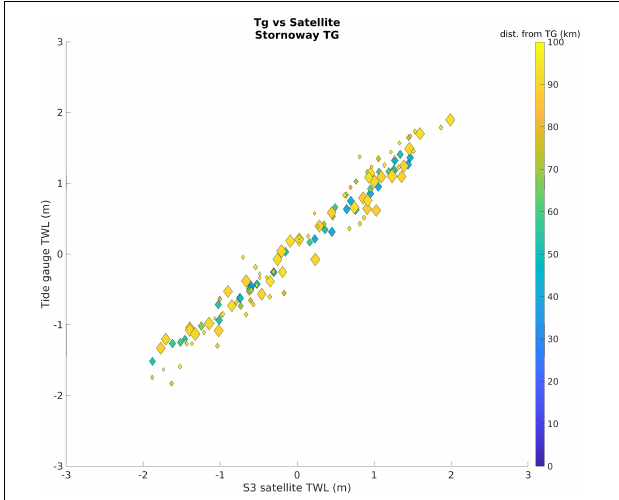
FIGURE 3 | Comparison of S3 with TG at Stornoway, which had the lowest error of all stations considered. The color shows the distance of the Satellite from the TG (blue is at the TG location; yellow is up to 100 km away from the TG). The marker size indicates the distance of the satellite from the coast (The smallest markers are within 1 km of the coast, the widest markers are up to 50 km from the coast). Note that the distance of the satellite from the TG has a smaller impact than the distance to the coast over the results.